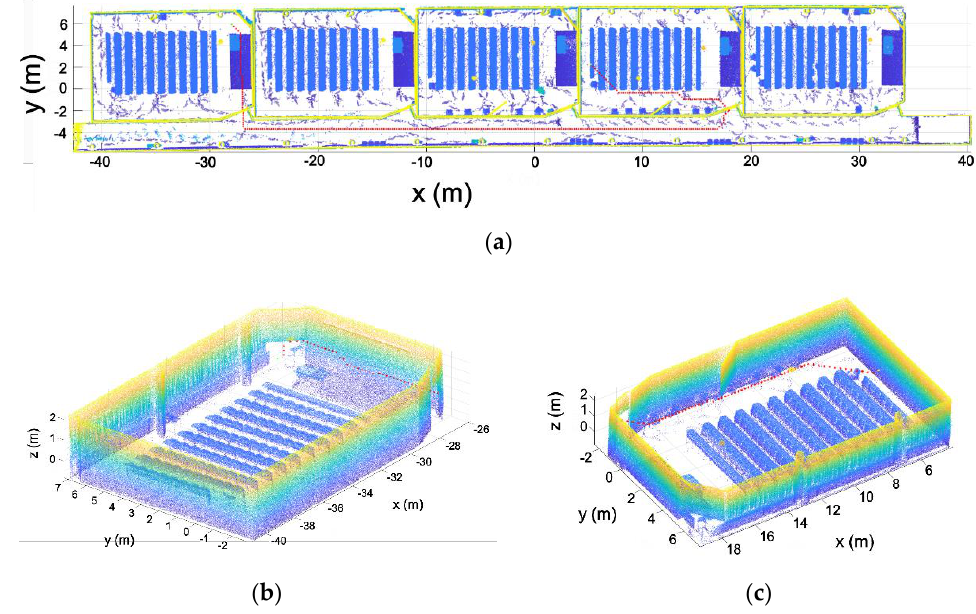
Figure 15. Path calculated between two different rooms (red: Waypoints; green: Initial position; yellow: Final position). ( a ) Complete path. ( b ) Initial room path. ( c ) Final room path.